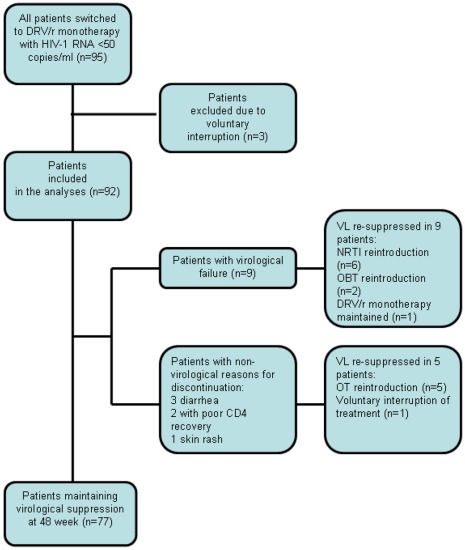
Summary of effectiveness results.Abbreviations: NRTI, nucleoside reverse transcriptase inhibitors; DRV/r, darunavir/ritonavir; OT, optimized treatment.